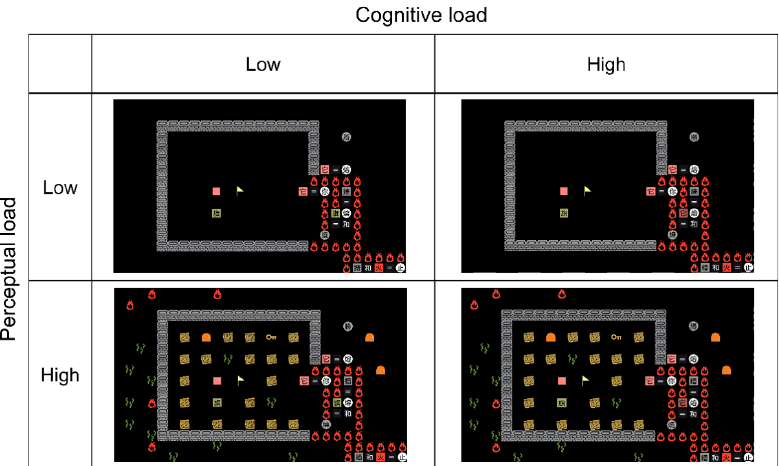
Figure 3. An example of the four mental workload conditions adopted in the experiment.